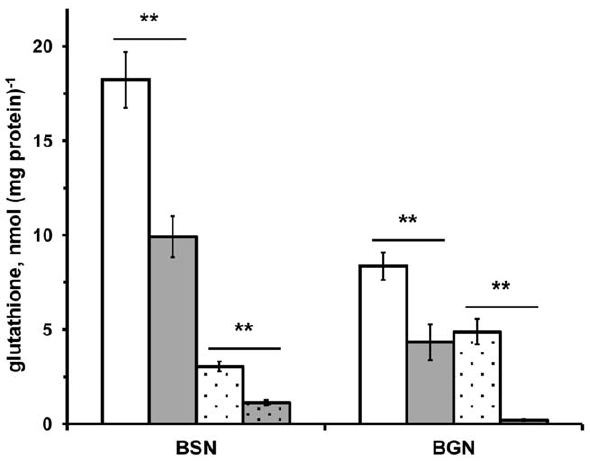
Figure 2. Glutathione in A.vinelandii . ( A ) Glutathione was detected in wild-type (UW136; white bars) and in RhdA-null mutant (MV474; grey bars) A. vinelandii strains grown in Burk’s medium containing sucrose (BSN) or gluconate (BGN) as carbon source in the absence (not-dotted bars) and in the presence (dotted bars) of phenazine methosulfate (PMS). Measured glutathione includes both the total reduced-glutathi- one and the DTT-reducible fraction of total free glutathione and is expressed as function of the protein amount detected in 10 mM Tris- HCl 0.1 M NaCl (pH 8) extracts of cell-samples from the same growths. All data are the mean of three independent replicates 6 standard deviation. Differences significant for P , 0.01 (**) are indicated (Student’s t test).